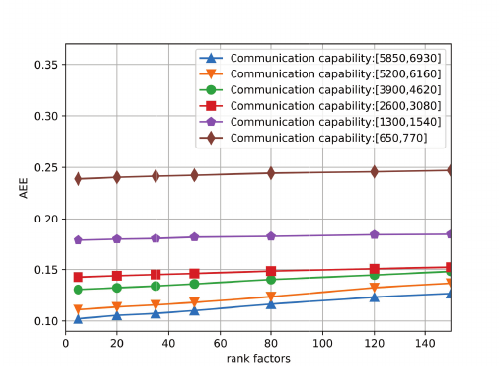
Figure 7. The AEE of the proposed algorithm under different rank factors.